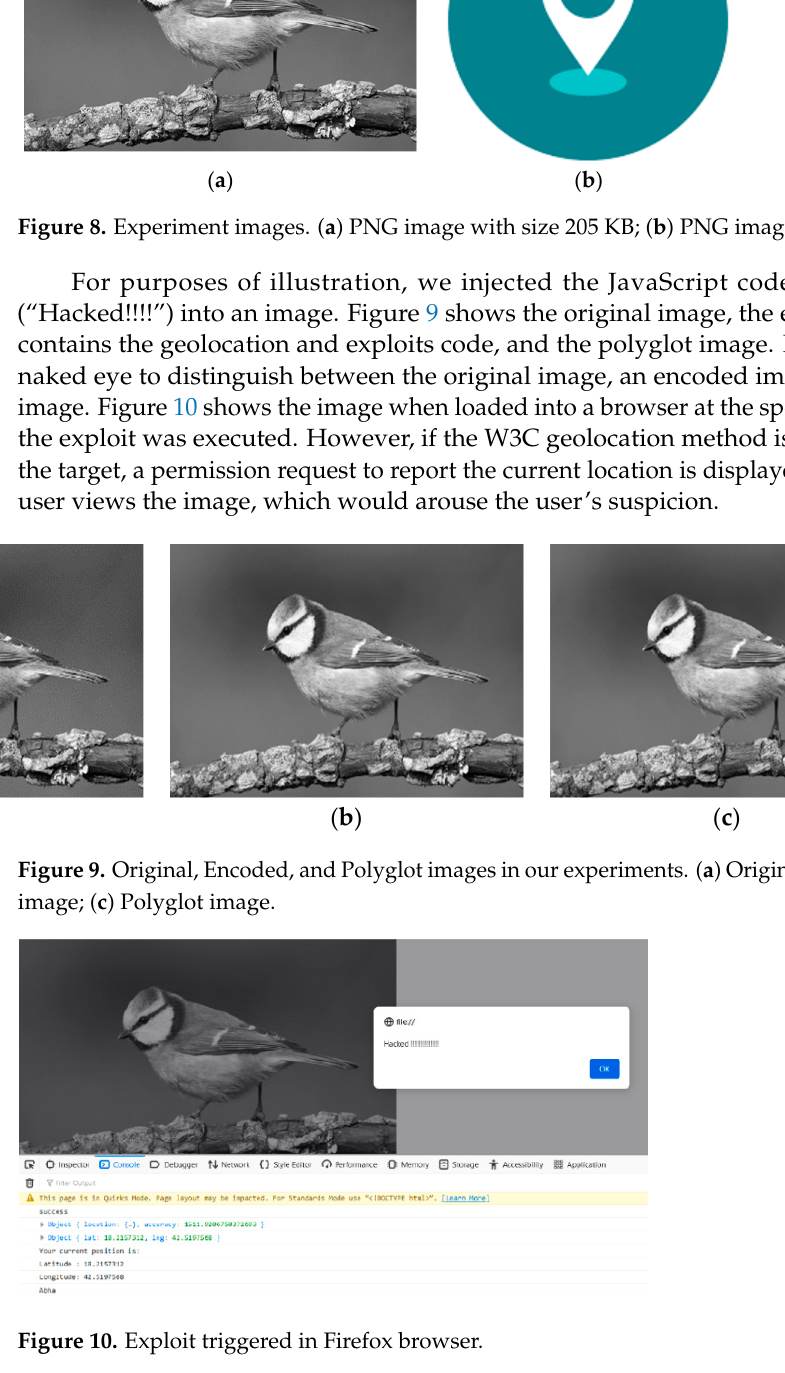
Figure 11. The original image file structure is in hexadecimal view.